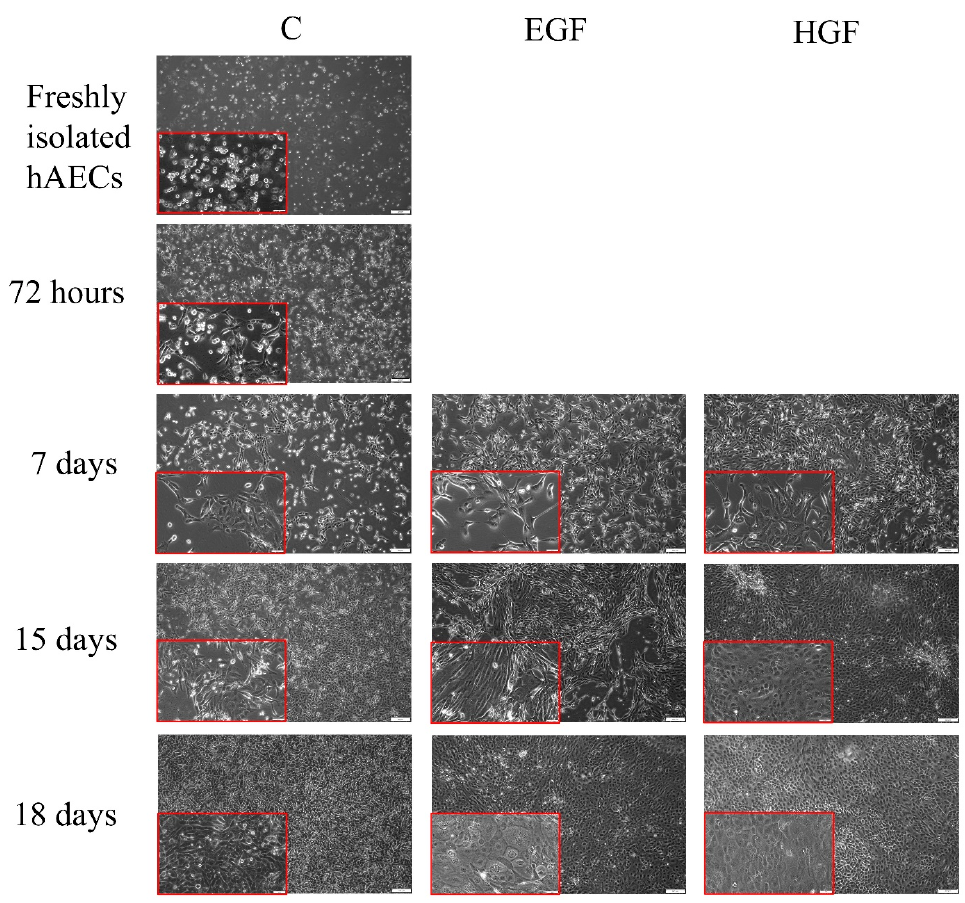
Figure 1. Comparison of the morphology of native hAECs in primary culture and in the control group as well as those differentiated in EGF- and HGF-supplemented media. Magnification—100×; scale—100 µm. In red frames: magnification—200×; scale—50 µm.